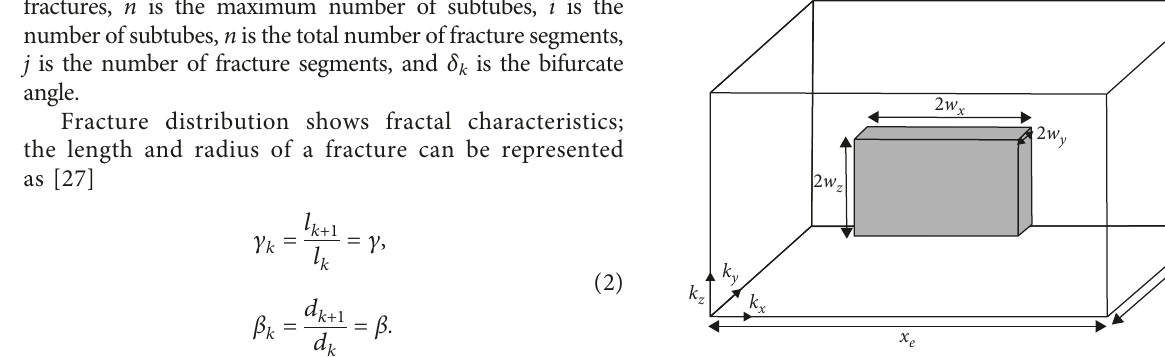
Figure 3: Schematic of the box-in-box model